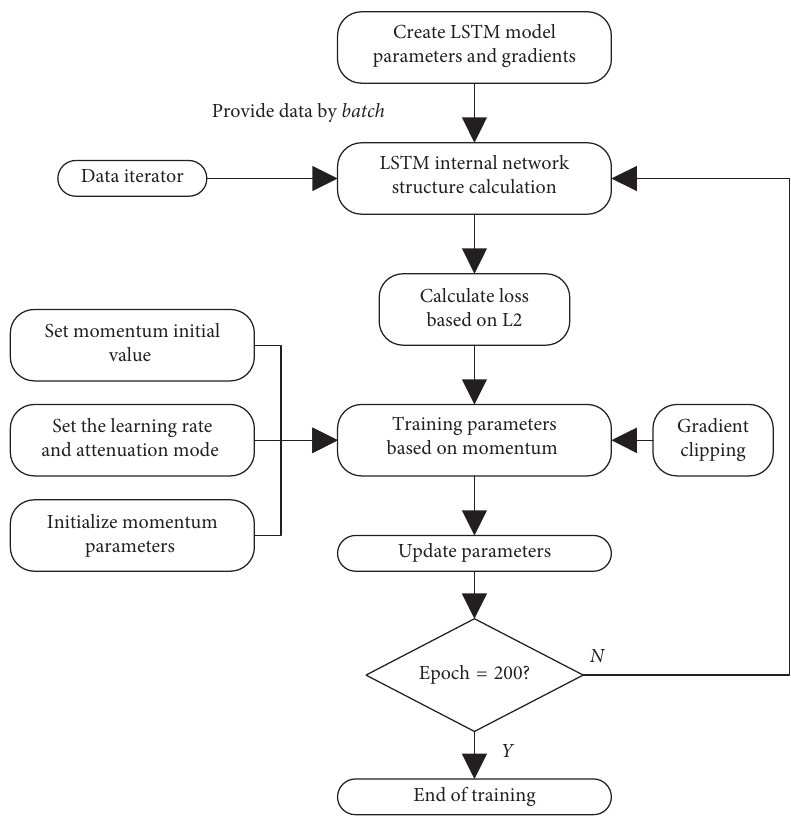
Figure 3: Training process of the LSTM